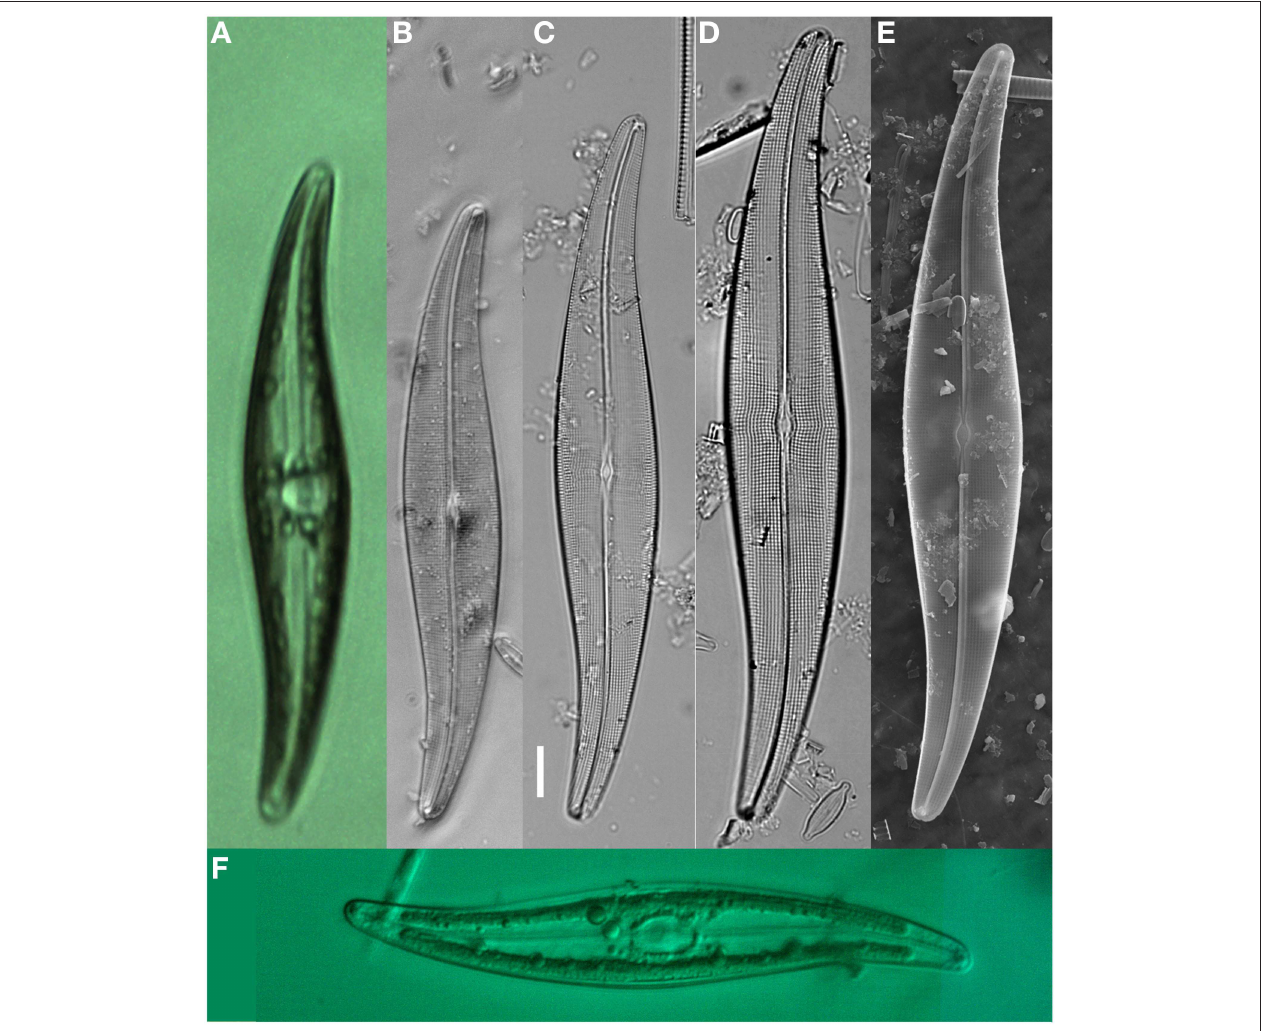
FIGURE 3 | Gyrosigma acuminatum shown as live, fixed and cleaned specimens with light microscopy (LM) and scanning Electron microscopy (SEM). (A) Live specimen from NHC pond (sequenced for rbcL), low magnification showing valve outline, and cytoplasmic structure. (B–D) LM micrographs showing the size reduction series from one sample location. (E) SEM illustration the internal view of the valve. (F) LM image of an RNA later fixed specimen after freezing at − 20 ◦ C and thawing. Scale bar = 10 µ